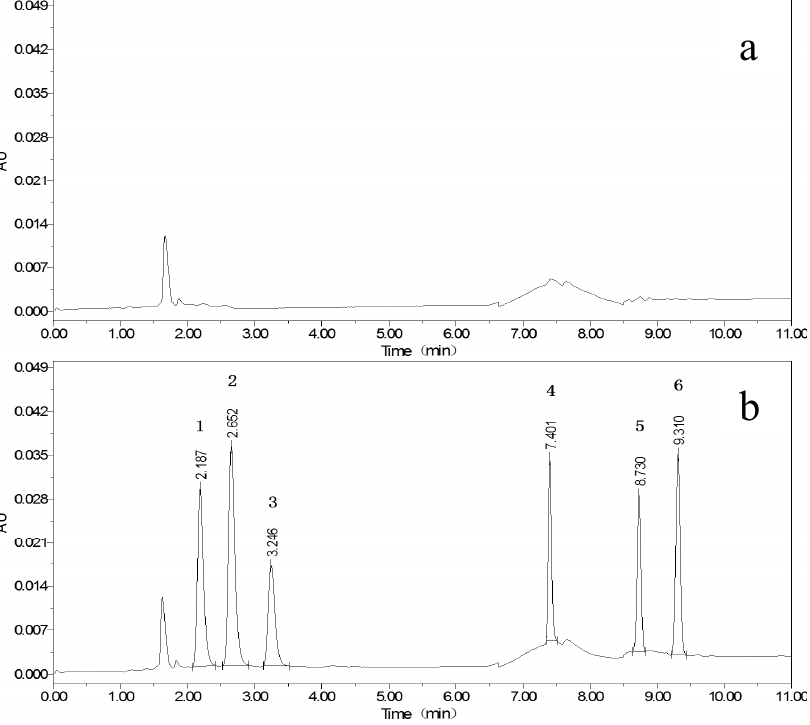
Figure 3. Chromatograms of blank egg white ( a ); and blank egg white with 100 µg/kg mixed standards ( b ) (ABZSO 2 NH 2 (1), ABZSO (2), ABZSO 2 (3), ABZ (4), AVM (5), IVM (6)). The presence of conjugated saturated and unsaturated bonds and heteroatoms such as nitrogen, sulfur, and oxygen in the structures of the targets renders them UV active compounds [30]. Nevertheless, the spectral properties are not absolute and are con- strained by the chemical circumstances [30]; thus, the absorption spectrum of the targets was captured under optimized chromatographic conditions. The results indicated that both ABM and IVM had strong absorption at 244.2 nm; ABZ had strong absorption at 204.1 nm, 230.0 nm and 302.3 nm; ABZSO 2 , ABZSO and ABZSO 2 NH 2 had strong absorp- tion at 220.0 nm and 290.0 nm, and the response values were higher at 220.0 nm than at 290.0 nm, but the ABZ peak was interfered by the solvent peak at 220.0 nm. Eventually, 244.0 nm was selected as the detection wavelength for ABM and IVM, 302.0 nm for ABZ, and 288.0 nm for ABZSO 2 , ABZSO and ABZSO 2 NH 2 based on the response of the targets and the interference of the solvent peaks. The corresponding detection wavelength of the target is different from the related reports. The detection wavelengths of both ABM and ABZ were assigned at 210 nm by Ali et al. [29]. The detection wavelengths of both IVM and ABZ were configured at 245 nm by Waldia et al. [31]. The detection wavelengths of both IVM and ABZ were fixed to 292 nm by Pawar et al. [30]. Permana et al. set the detec- tion wavelength of ABZ and two metabolites (ABZSO 2 and ABZSO) at 290 nm and that of IVM at 245 nm [22]. 3.3. Analytical Method Validation In this study, LODs of 3.2 − 9.8 µg/kg and LOQs of 7.9 − 26.6 µg/kg in whole egg were achieved, as illustrated in Table 2. The acquired LODs range in egg yolk and egg white are 2.6 − 10.5 µg/kg and 2.1 − 8.6 µg/kg, respectively, and the achieved LOQs range in egg yolk and egg white are 8.1 − 28.4 µg/kg and 7.8 − 25.0 µg/kg, respectively.